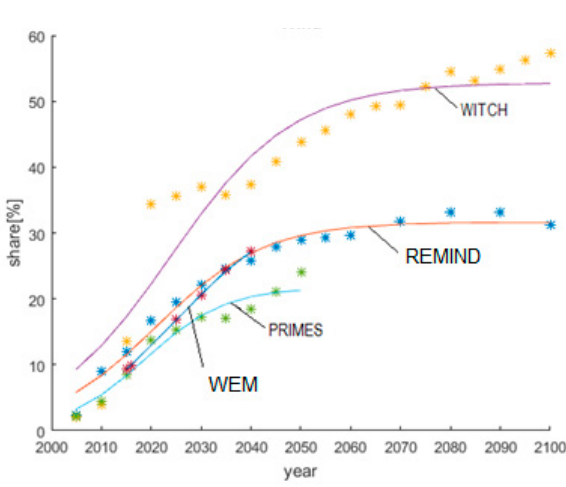
Figure 14. Reference scenarios for WEM, WITCH, PRIMES and REMIND programs for Europe’s wind power energy generation share (own work).